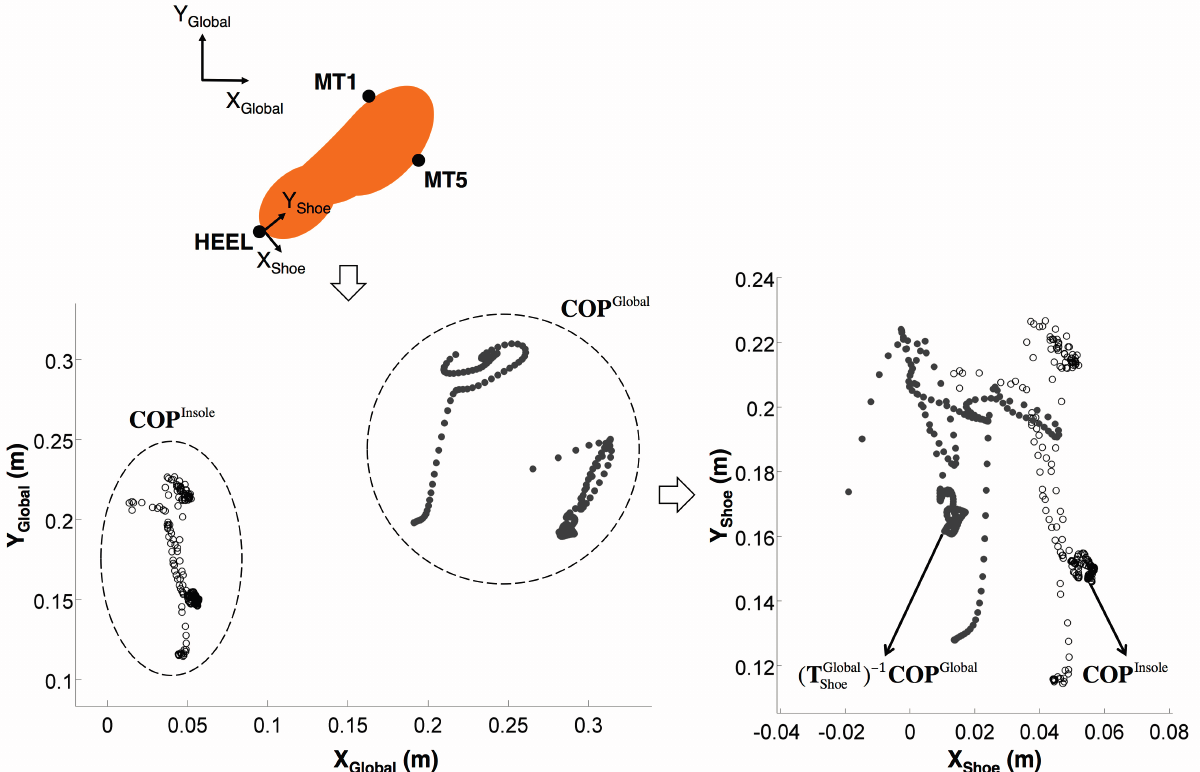
Figure 1. Overview of current transformation problem, specifically involving defining a (cid:2879)(cid:2869) transformation matrix, (cid:1794) (cid:2893)(cid:2924)(cid:2929)(cid:2925)(cid:2922)(cid:2915)(cid:2903)(cid:2918)(cid:2925)(cid:2915) between (cid:3435)(cid:1794) (cid:2929)(cid:2918)(cid:2925)(cid:2915)(cid:2891)(cid:2922)(cid:2925)(cid:2912)(cid:2911)(cid:2922) (cid:3439) (cid:1777)(cid:1789)(cid:1790) (cid:2891)(cid:2922)(cid:2925)(cid:2912)(cid:2911)(cid:2922) and (cid:1777)(cid:1789)(cid:1790) (cid:2893)(cid:2924)(cid:2929)(cid:2925)(cid:2922)(cid:2915) . Here, MT1, MT5, and HEEL, respectively, indicate passive reflective markers on the 1st and 5th metatarsal heads and calcaneus. The subscripts Shoe/Global on the axis labels indicate the shoe/global coordinate